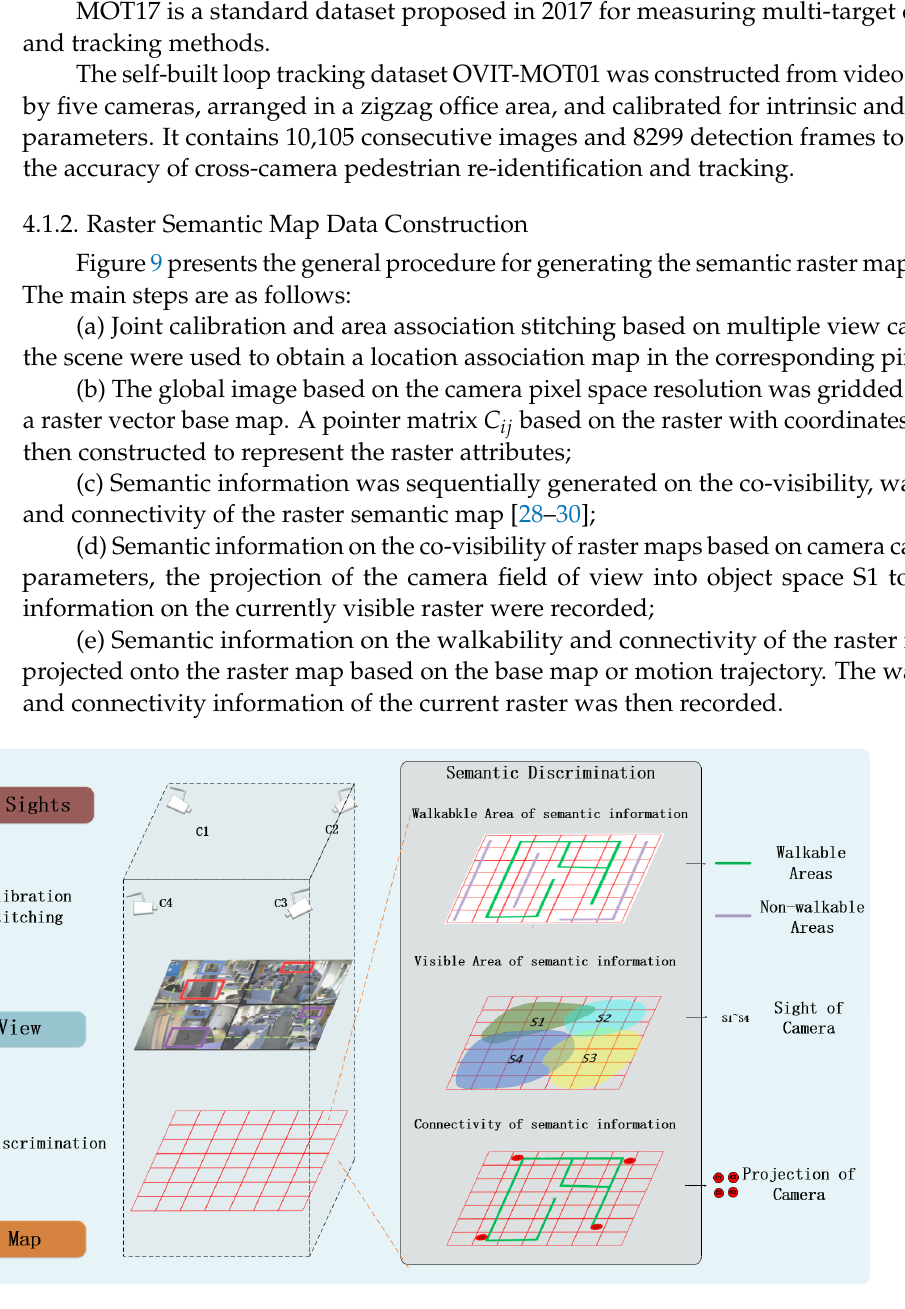
Figure 9. Semantic raster map construction.